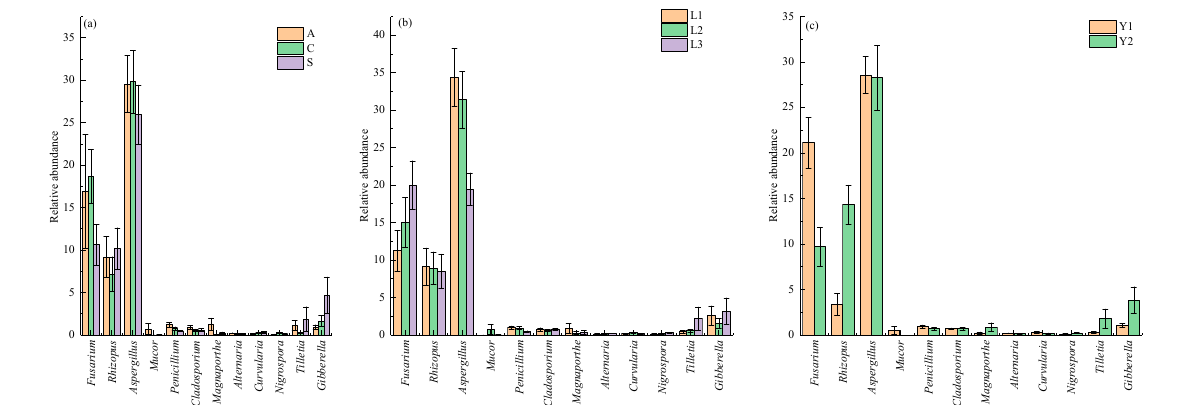
Figure 5. The relative abundance variation of 30 fungal genera in different orientations, vertical positions and storage times. The results of different orientation, vertical position, and storage time effect on fungi are show in ( a ), ( b ) and ( c ),